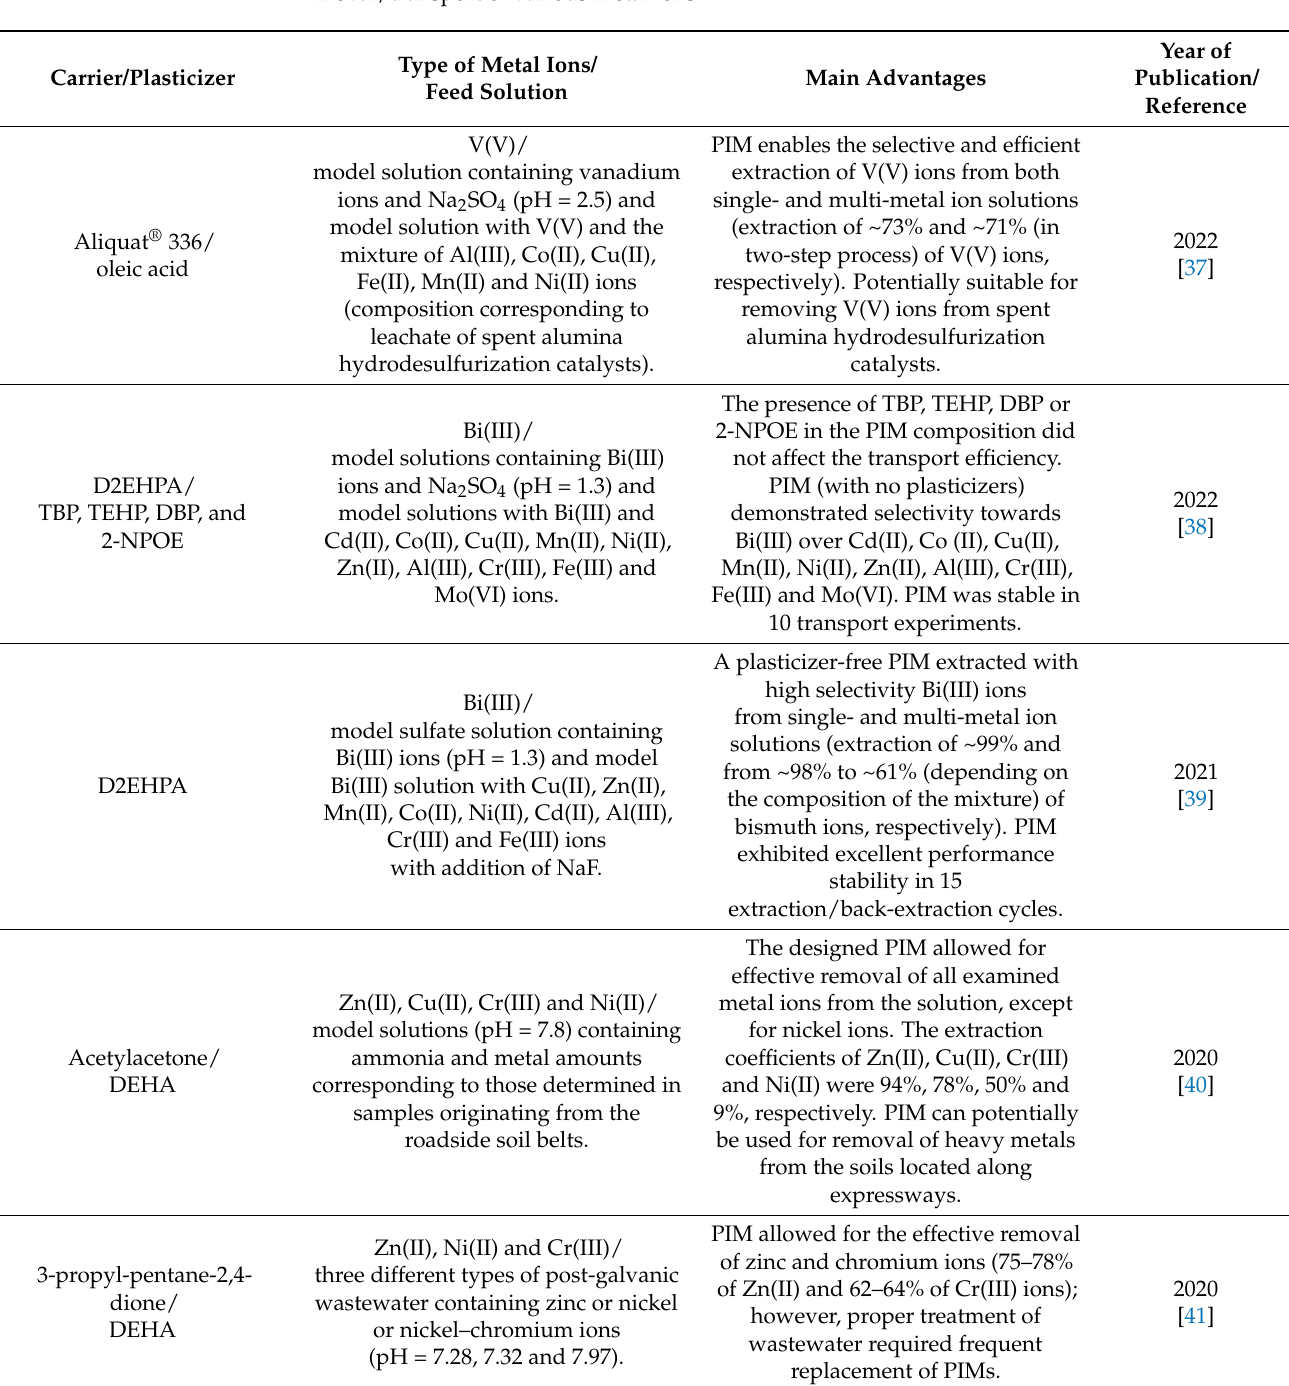
Table 1. Examples of PIMs prepared using PVC as base polymer and their applications for re- moval/transport of various metal